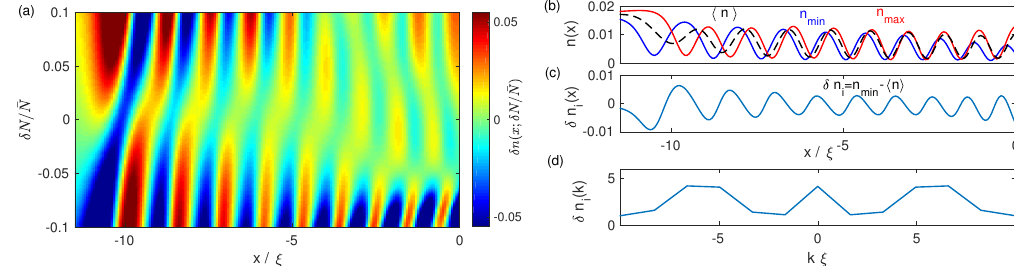
Figure 7: Effects of atom-number variation on the standing wave. (a) density variation, δ n = n −〈 n 〉 , as a function of position, for atom number N = ¯ N + δ N . (b) dashed black: aver- aged density over atom-number fluctuation, ∆ N / ¯ N = 0.05; solid red: density of a realization with atom number N = ¯ N + 0.075 ¯ N , n ; solid blue: one with atom number N = ¯ N − 0.075 ¯ N , max − 〈 n 〉 . n . (c) difference between the density with N and the averaged density, δ n = n min min min (d) wavevector spectrum for δ n ( x ) in a region near the BH, − 5.6 ξ < x < − 1.8 ξ . − 〈 n 〉 is shown while for n it shifts towards the left. The density variation δ n = n min min